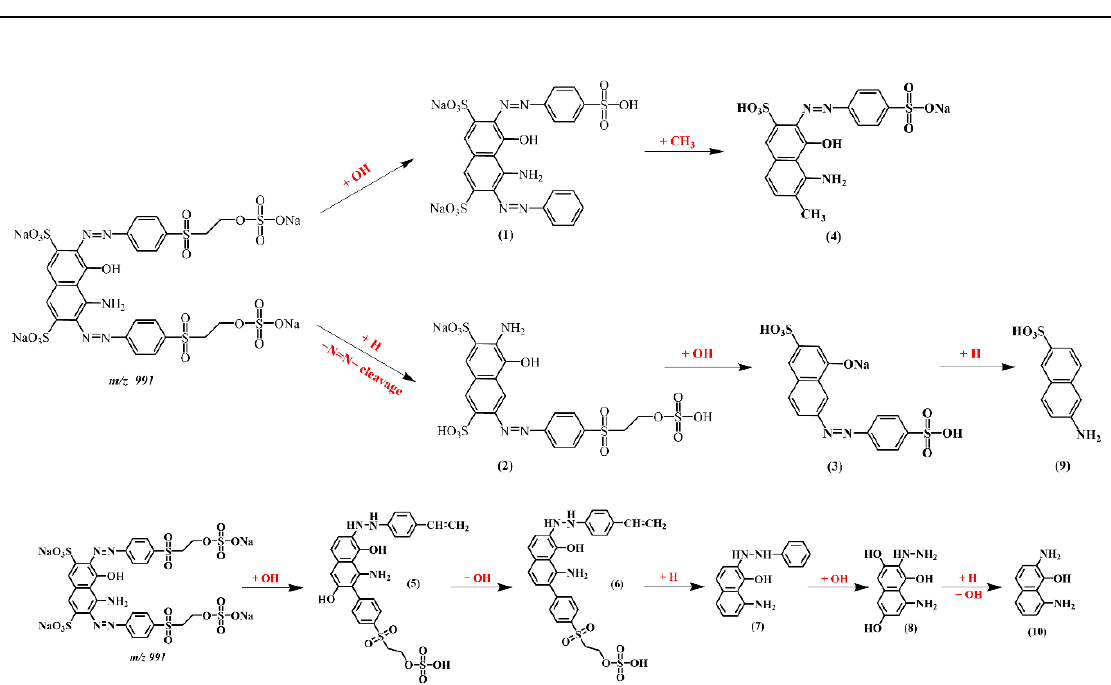
Figure 6. Proposed degradation pathways of RB5 in Fe 2+ /PAA/H 2 O 2 system.